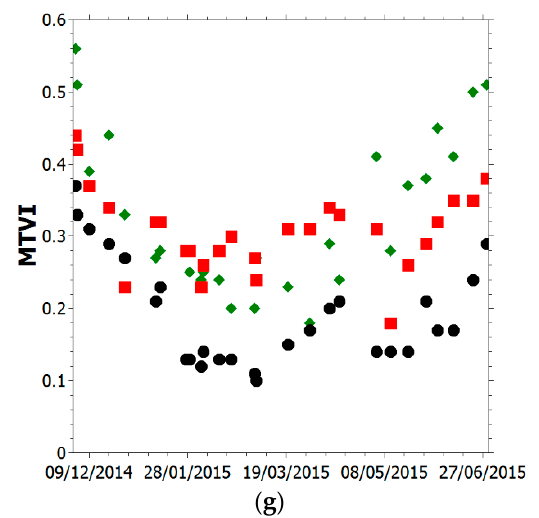
Figure 5. Vegetation indices during the monitoring period. Carpobrotus, Cerastium and Dianthus VIs are indicated with black, red and green marks, respectively. ( a ) Red DVI; ( b ) Red NDVI; ( c ) NDVI; ( d ) EVI; ( e ) GEMI; ( f ) TVI; ( g ) MTVI